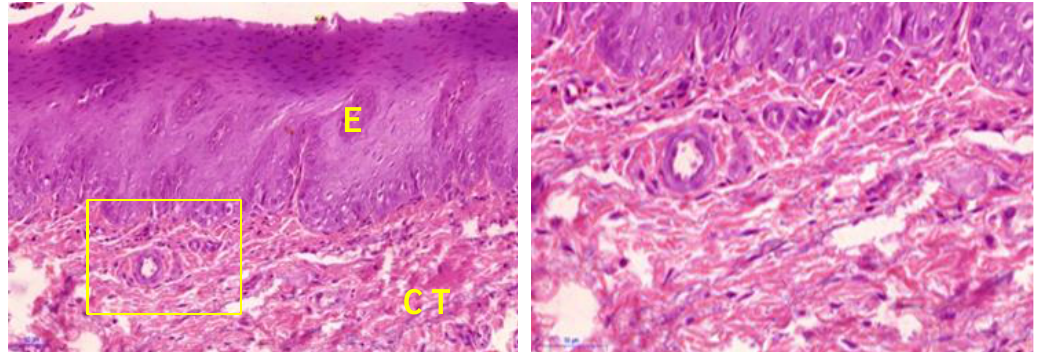
Figure: 7 Microphotograph of study group treated with gingival sulcular irrigation of 50 μL/kg of 5% green tea extract after three days showing a mild inflammatory reaction, no ulcerative epithelia (E) with remodeling fibrous connective tissue (CT). H&Ex20, x40.